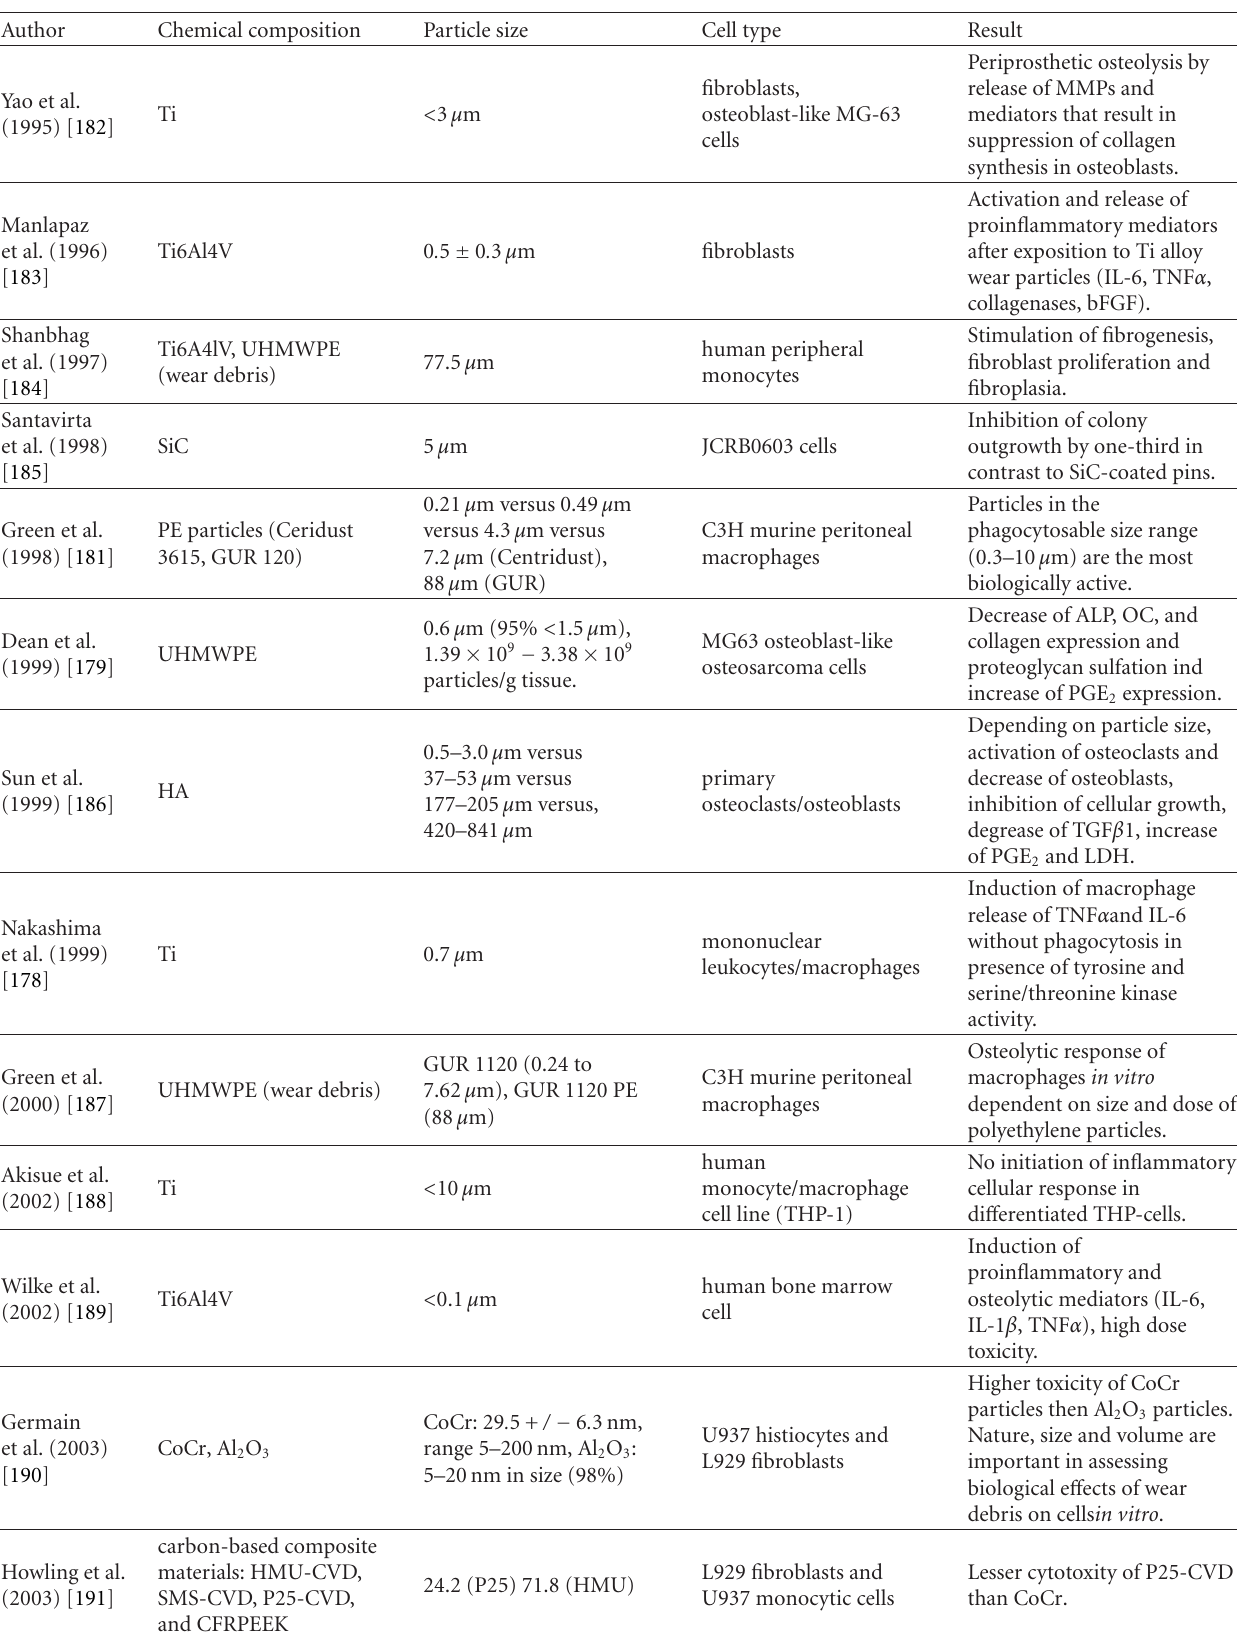
Table 2: Results of in vitro cytocompatiblity of di ff erent nano- and